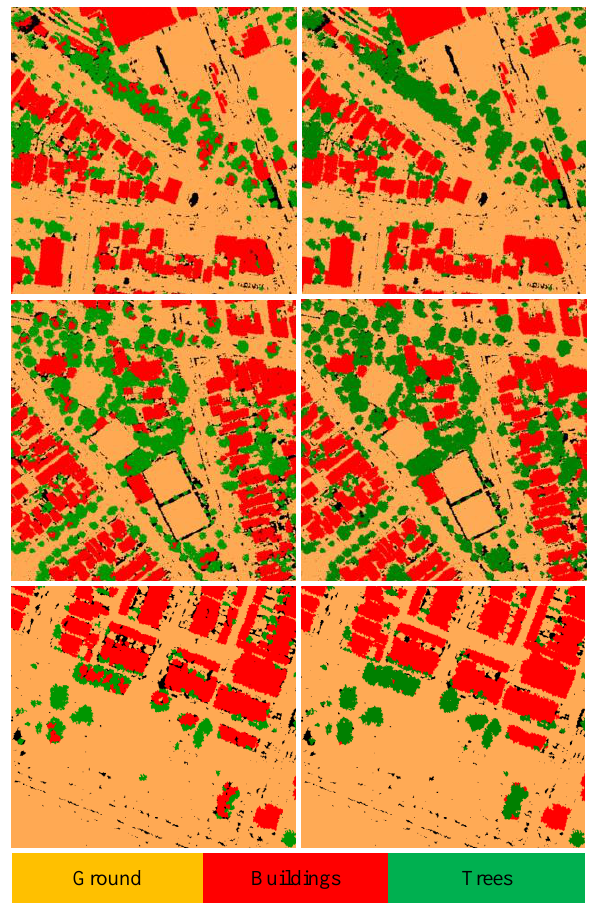
Figure 8. Tree canopy cover map before (left) and after (right) removal of gaps, tree (white) and non-tree (black).